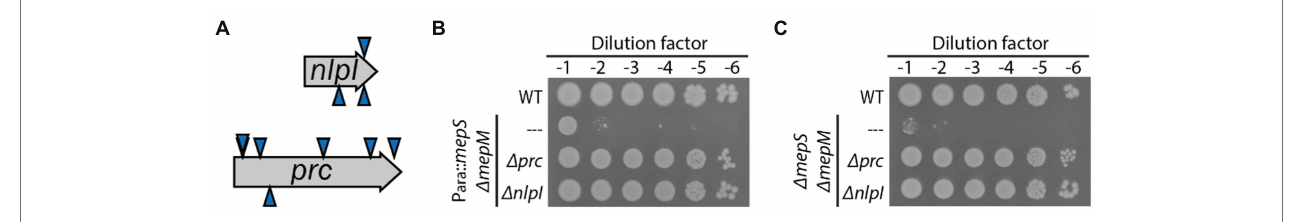
FIGURE 2 | Inactivation of prc or nlpI suppresses the synthetic lethality between mepS and mepM mutations. (A) A diagram of the transposon insertion sites of suppressors isolated from the selection of a random transposon insertion library of HC611 (P ara :: mepS , Δ mepM ) on LB agar. The triangles above the gene arrow represent the insertion for which the direction of transcription in the kanamycin resistance cassette of the transposon is in the same orientation as the disrupted gene; the triangles below, the opposite direction. (B) MG1655, HC611, and the Δ prc and Δ nlpI derivative strains of HC611 grown overnight in M9-arabinose medium were serially diluted in LB and spotted onto LB agar. The plates were incubated at 30 ° C and photographed after 22 h for comparison of growth phenotype. (C) MG1655, WJ310 ( Δ mepS Δ mepM ), WJ323 ( Δ mepS Δ mepM Δ prc ), and WJ324 ( Δ mepS Δ mepM Δ nlpI ) grown overnight in M9-glucose minimal medium lacking casamino acids were diluted, spotted, incubated, and imaged in the same way as in (B)